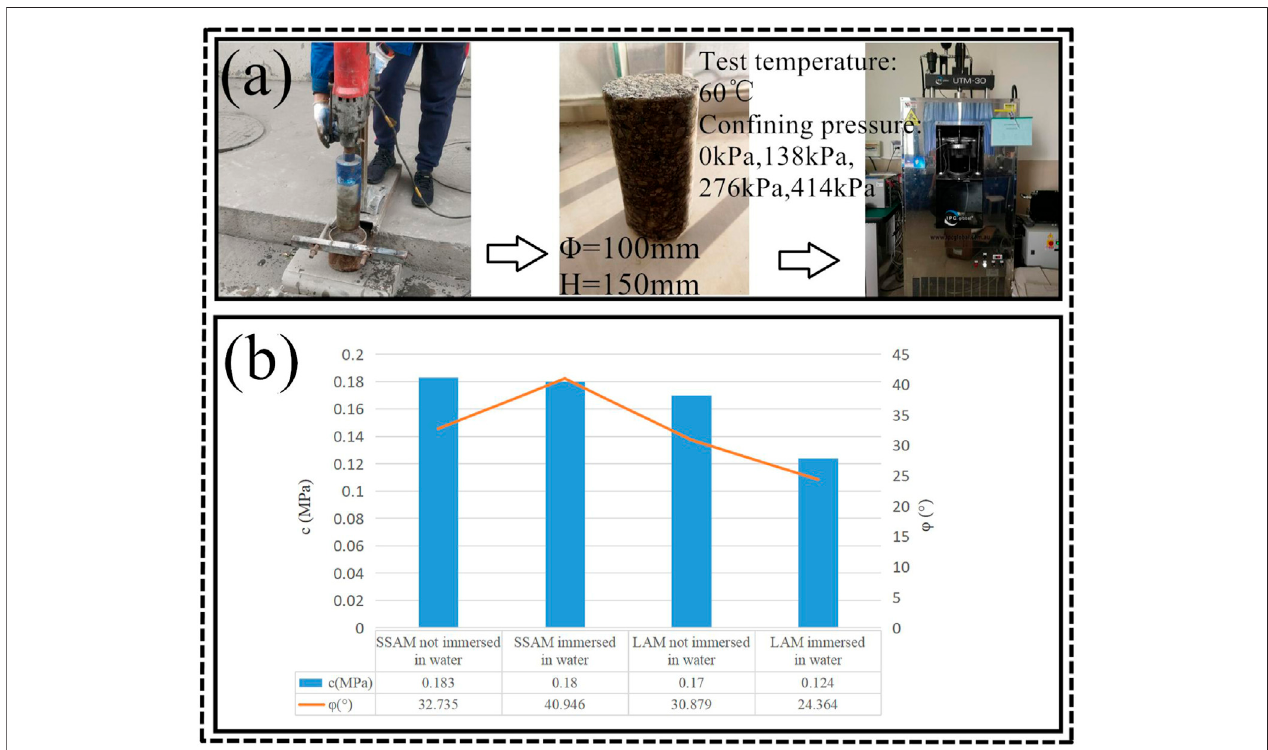
FIGURE 2 | Triaxial tests: (A) testing process and (B)